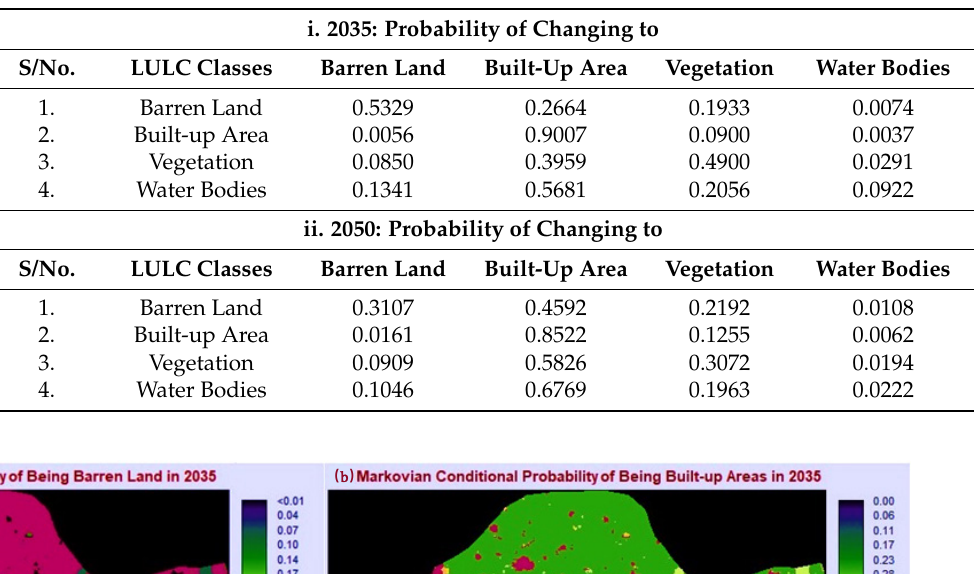
Table 5. Transition probability matrix (2010–2020).